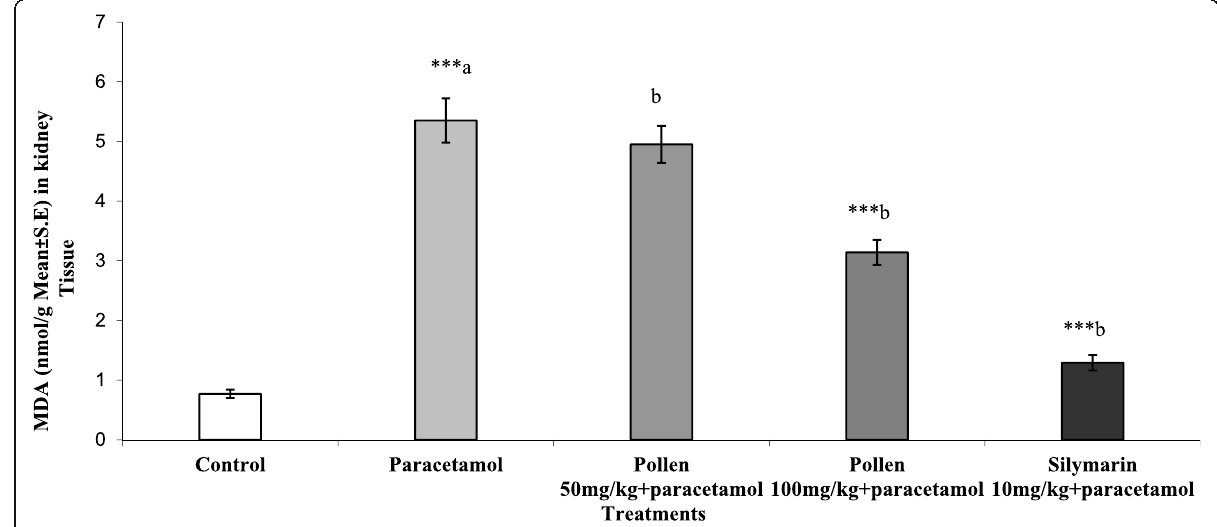
Fig. 4 Kidney tissue malondialdehyde (MDA) levels. MDA levels in rats intoxicated with APAP alone and treatment with DPP and Silymarin. All values represent mean ± SEM. *** p < 0.001; ANOVA, followed by Dunnett ’ s multiple comparison test. a As compared with control group. b As compared with APAP